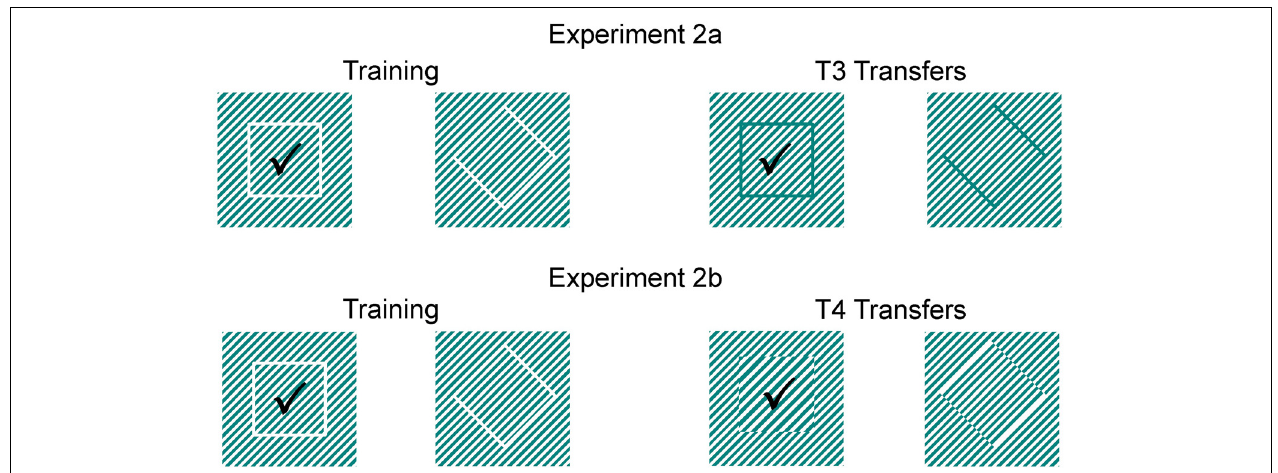
FIGURE 3 | Experiment 2. Shown are the stimuli presented to each group during regular training and transfer test trials. The positive, rewarded stimulus is marked by a checkmark. All sharks were trained to choose a white square presented on diagonal lines. During T3 transfer tests (2a), sharks were